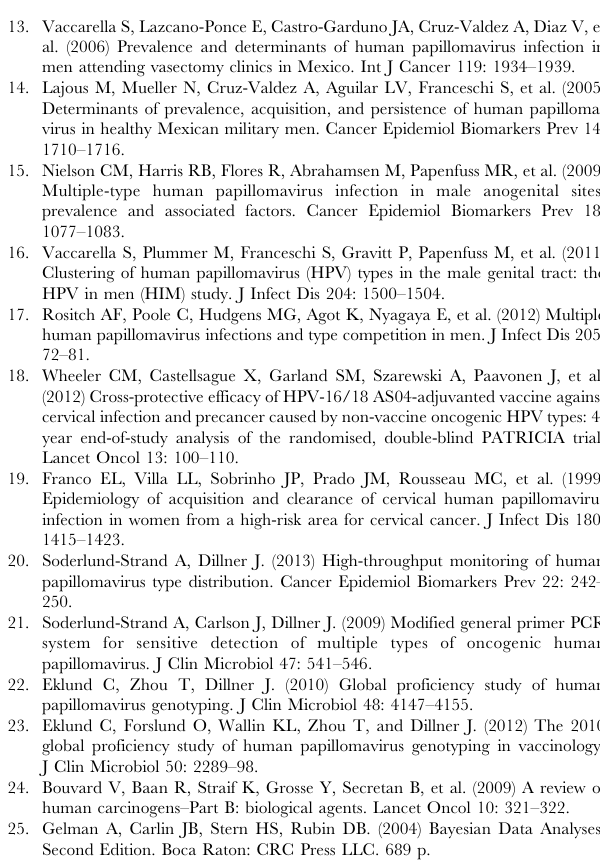
Table S1 Observed-to-expected ratio of multiple human papillomavirus infections, according to two models: